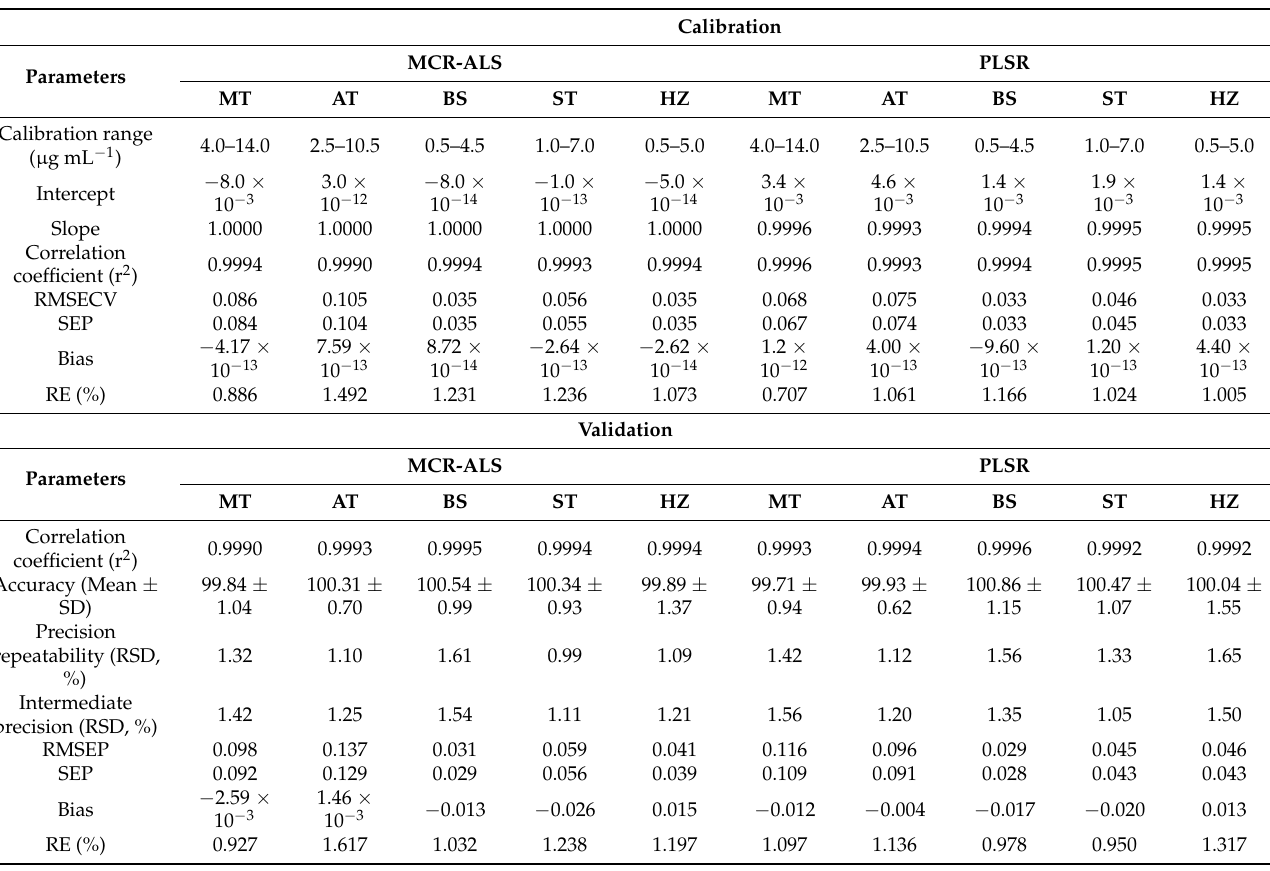
Table 2. Figures of merit of the developed MCR-ALS and PLSR models for the calibration and validation sets of the studied